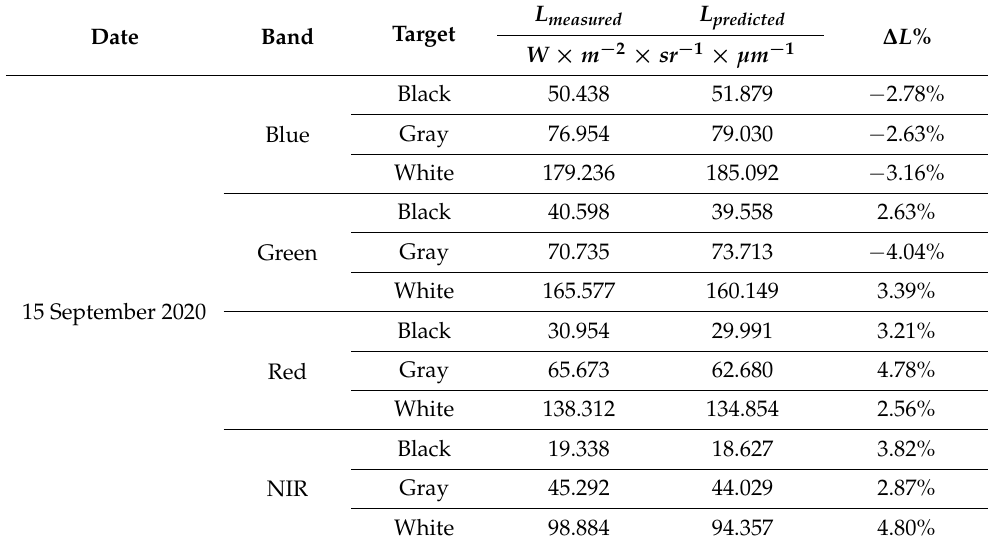
Table 6. The absolute radiometric calibration result of the GF-7 satellite at the Baotou site on 15